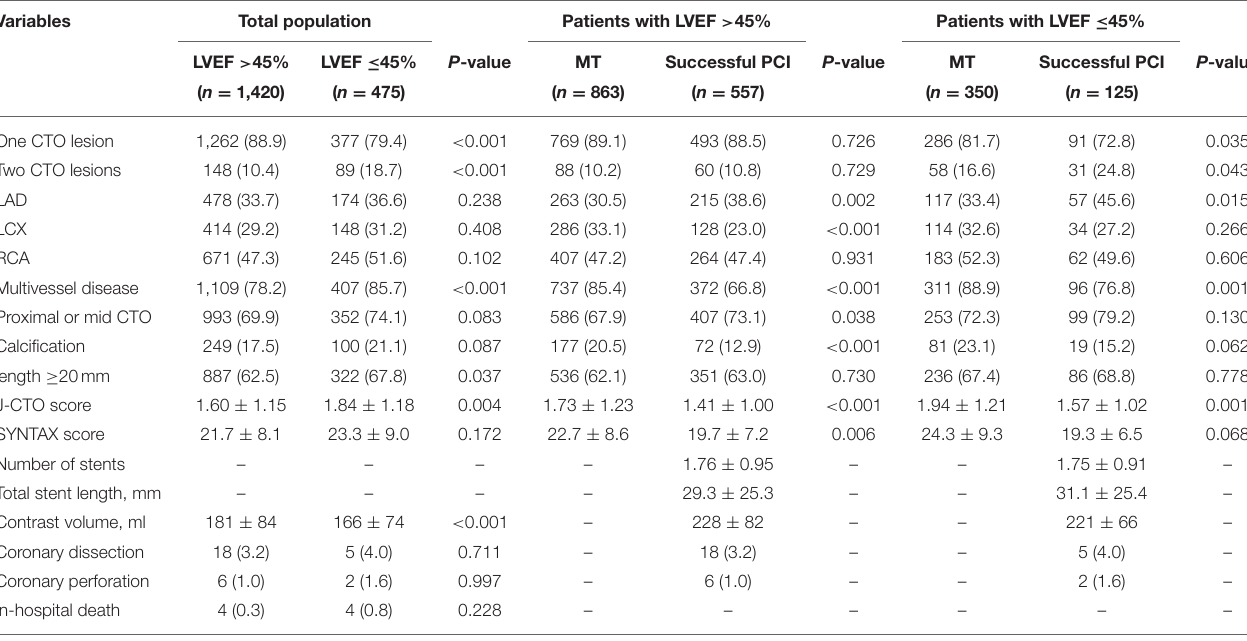
TABLE 2 | Baseline angiographic, procedural characteristics, and in-hospital outcome of all patients with and without left ventricular systolic dysfunction, and of patients with and without left ventricular systolic dysfunction stratified according to management. Variables Total population Patients with LVEF > 45% Patients with LVEF ≤